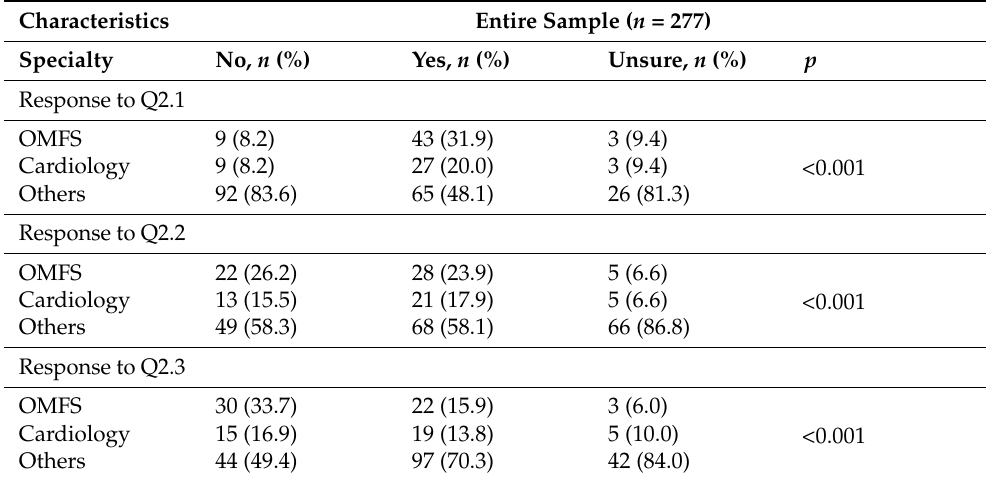
Table 4. Association between the specialists and their response to questions